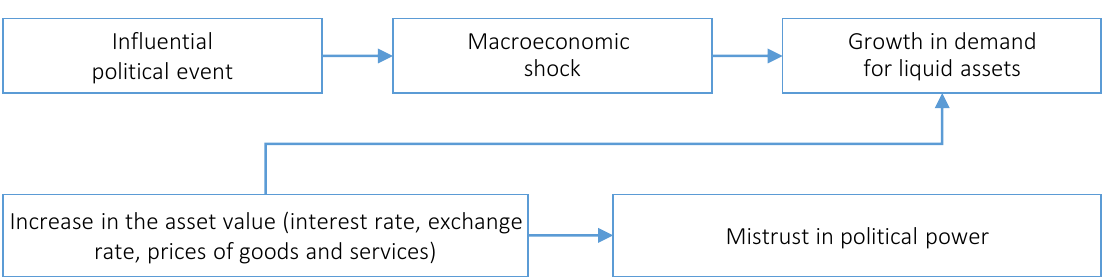
Macroeconomic shock